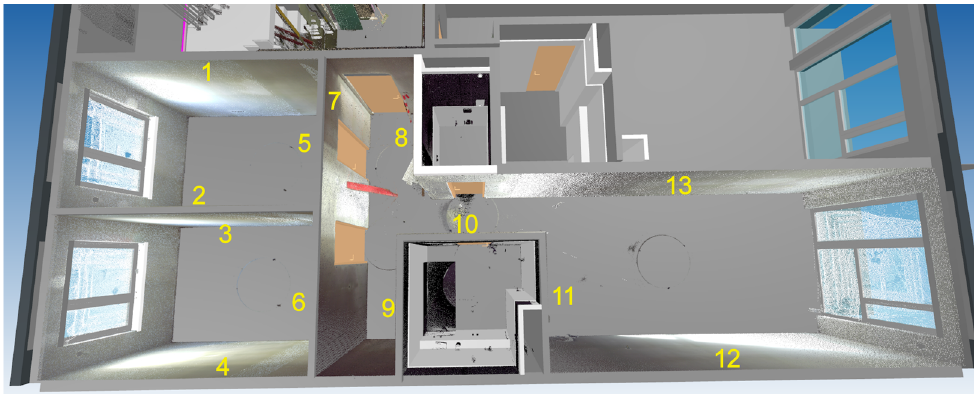
Figure 14. Case study object—BIM model with scanned point cloud and numbers of walls.